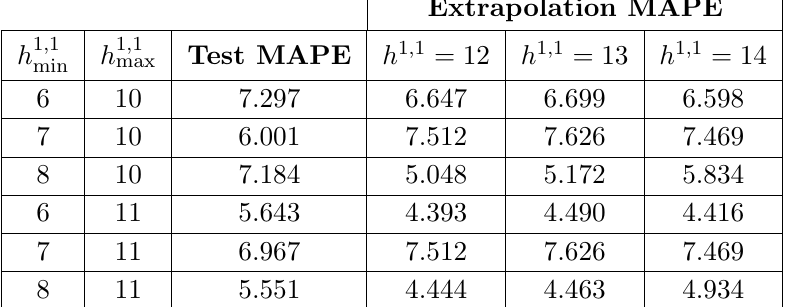
= 6, h 1 ; 1 = 11 max min